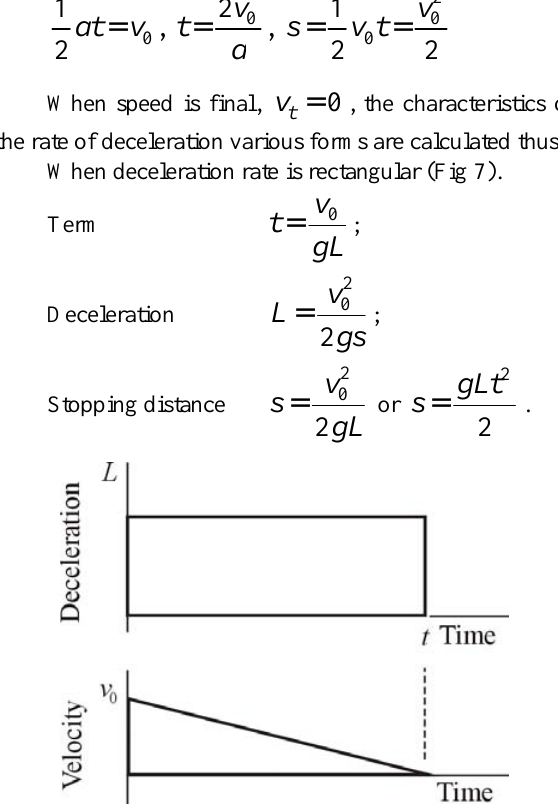
When speed is final, , the characteristics of the rate of deceleration various forms are calculated thus. When deceleration rate is rectangular (Fig 7).